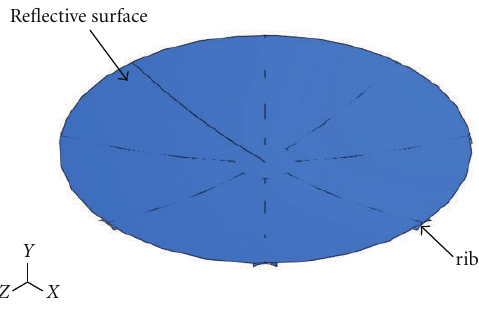
Figure 3: Reflective surface with tape springs, case T.